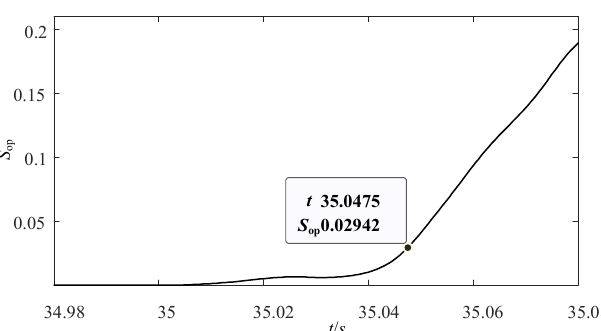
Figure 6. The action of the protection when the slip ratio s is 0.1.